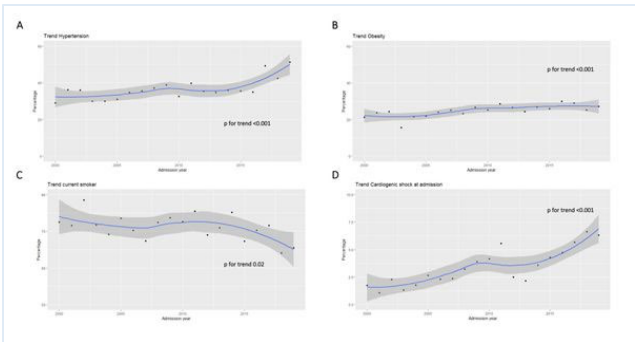
Figure . Twenty-year trends in the prevalence of (A) hypertension, (B) obe- sity, (C) active smoking, and (D) cardiogenic shock among young adults presenting with acute coronary syndromes in